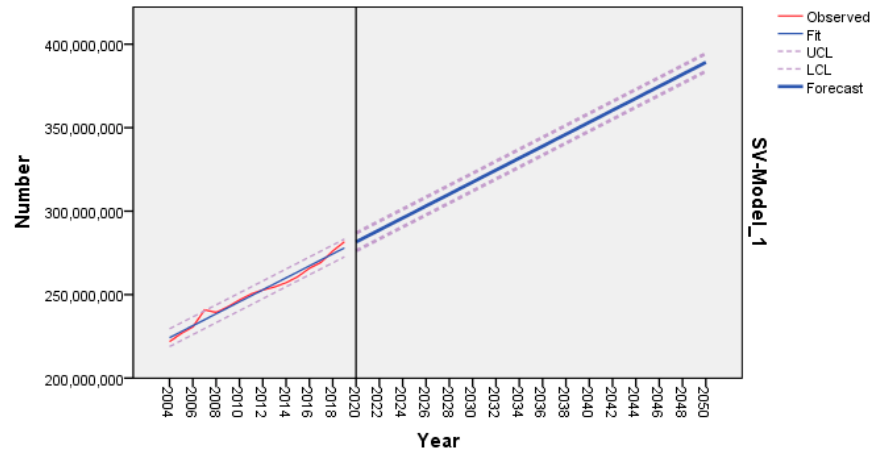
Table 3. Model fit for ARIMA forecast of the total number of vehicles used in the European Union for transport. Fit Statistic Mean Stationary R-squared 0.981 R-squared 0.981 RMSE 2,479,209 MAPE 0.734 MaxAPE 2.453 MAE 1,849,343 MaxAE 5,907,565 Normalized BIC 29.793